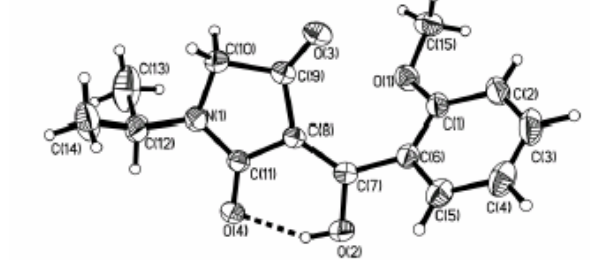
Figure 1 Molecular structure for the compound ( 3k ) with the atomic numbering